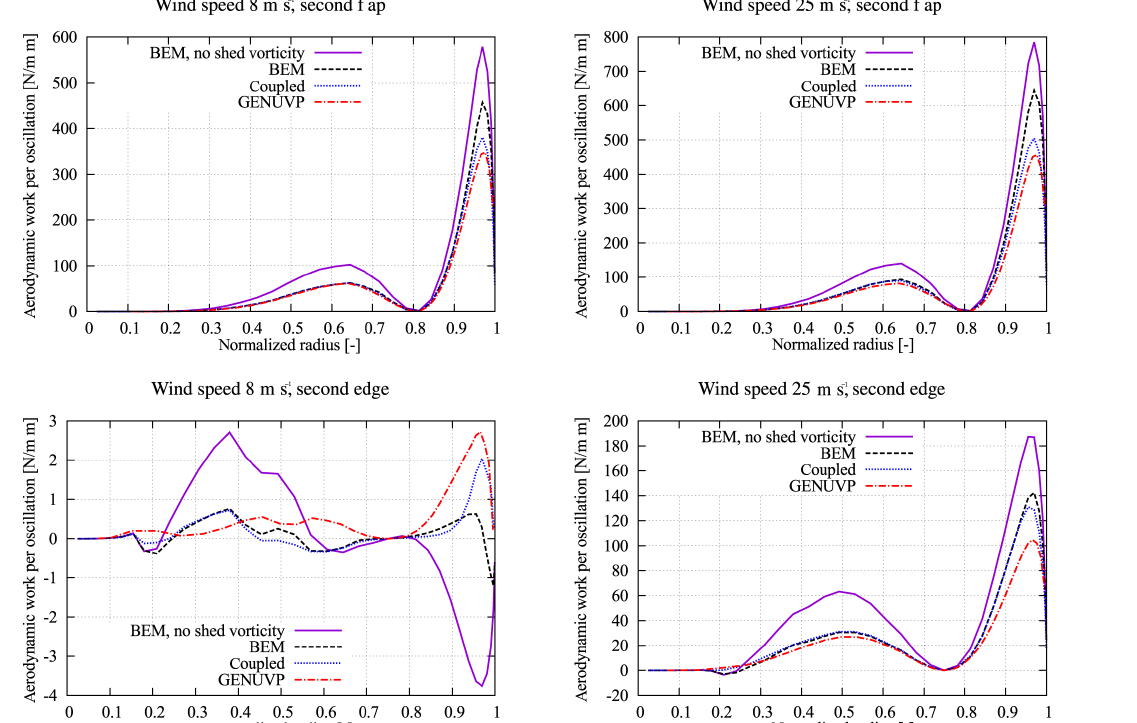
Figure 20. Aerodynamic work per oscillation of second flap (top) and edge (bottom) motion at 0.25m amplitude at 8ms − 1 (left) and 25ms − 1